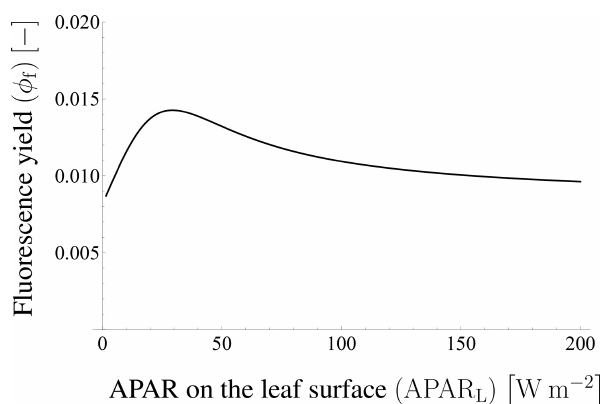
Figure 8. Fluorescence yield in Tol’s model. The fluorescence yield depends on APAR on the leaf surface. In this case, φ f is almost unchanged when APAR L is greater than 200Wm − 2